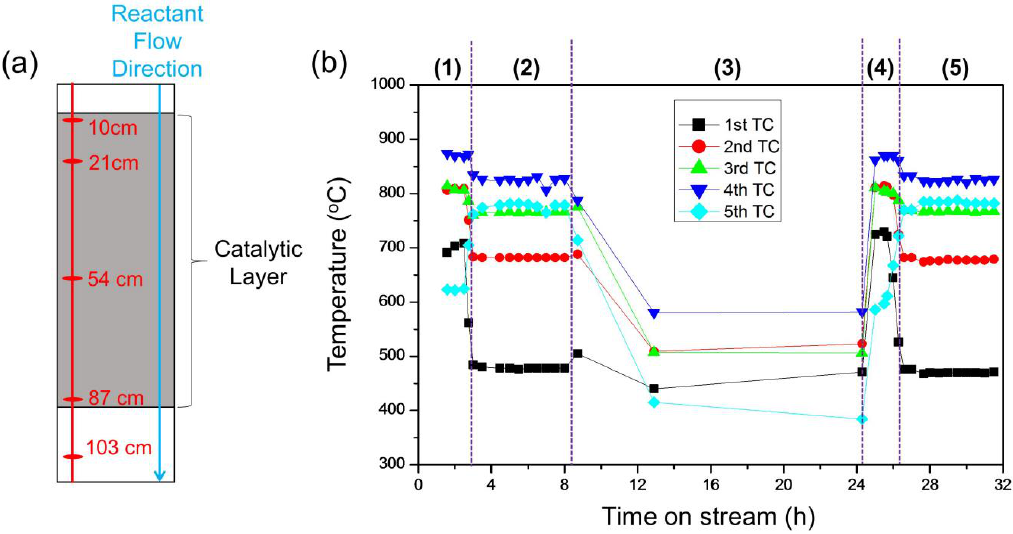
Figure 8. ( a ) Schematic of a catalytic layer for idling operation, ( b ) temperature recorded before (1, 2), during (3), and after idling (4, 5). Table 3. Comparison of temperature, methane conversion, and hydrogen production before and after idling.